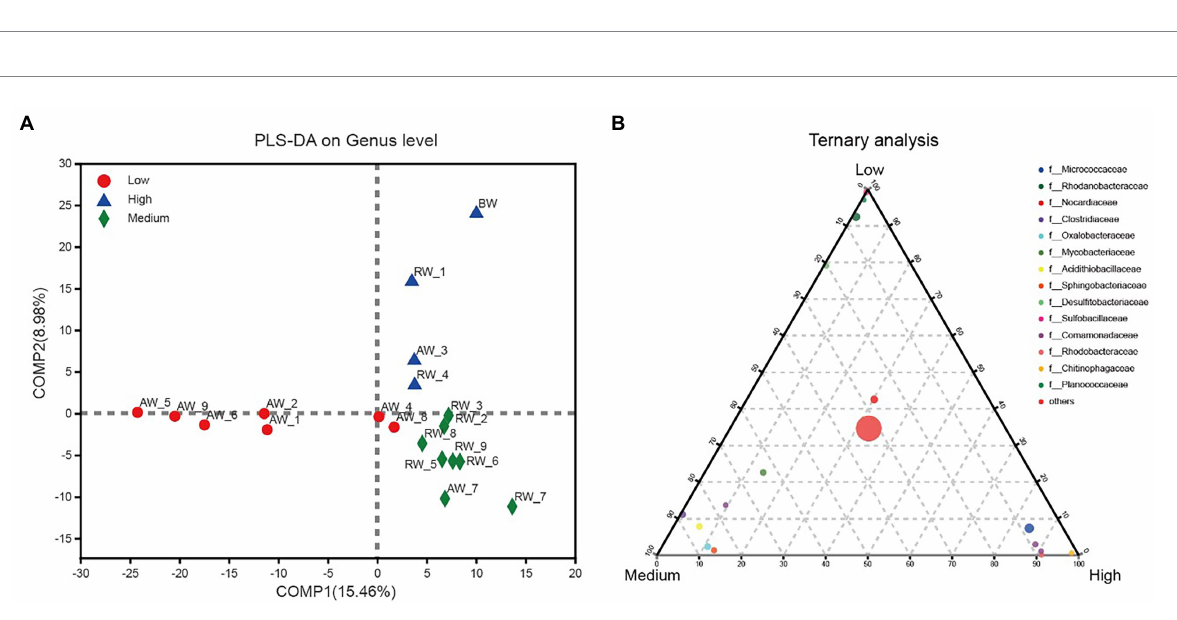
− 2 , respectively. (B) Distance-based redundancy 4 SO